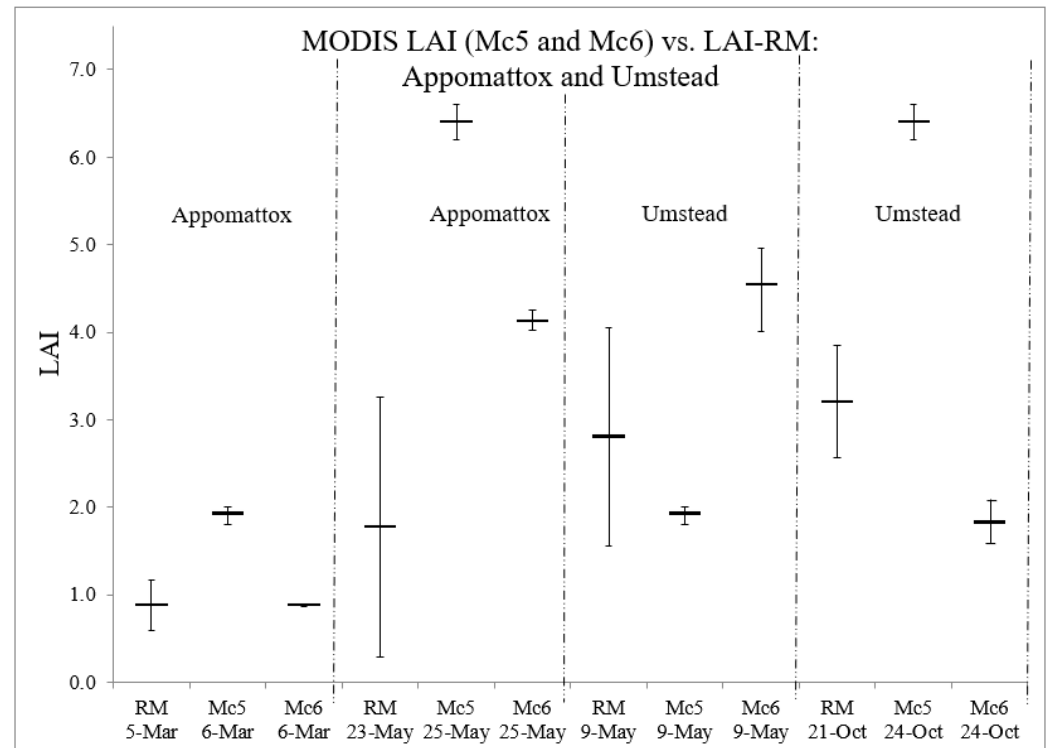
Figure 6. Appomattox and Umstead MODIS LAI (Mc5 and Mc6) comparisons to LAI-RM.